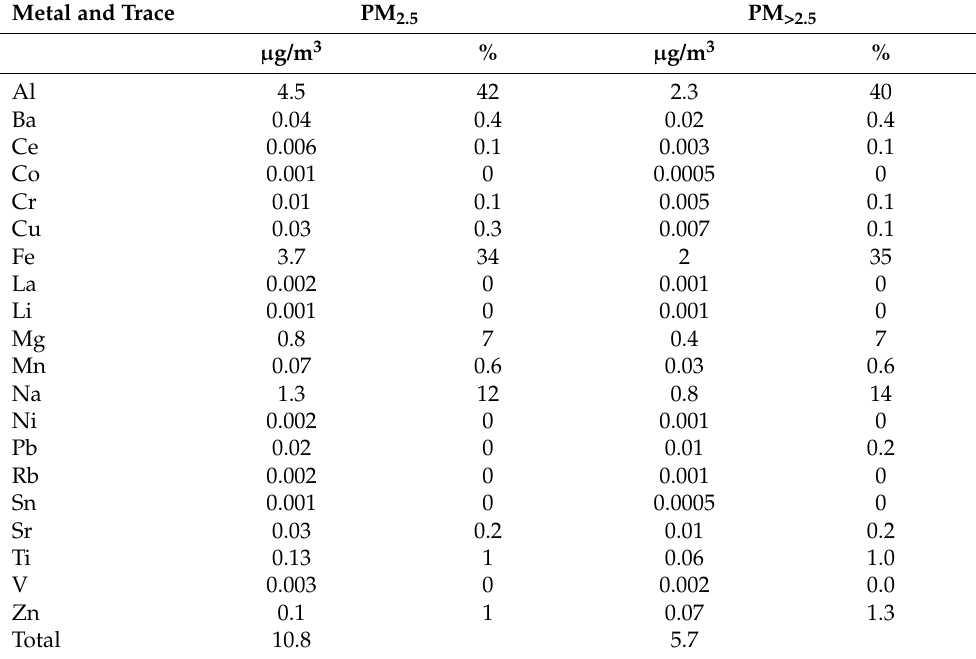
Table 2. Inorganic elements of air pollution particulate matter